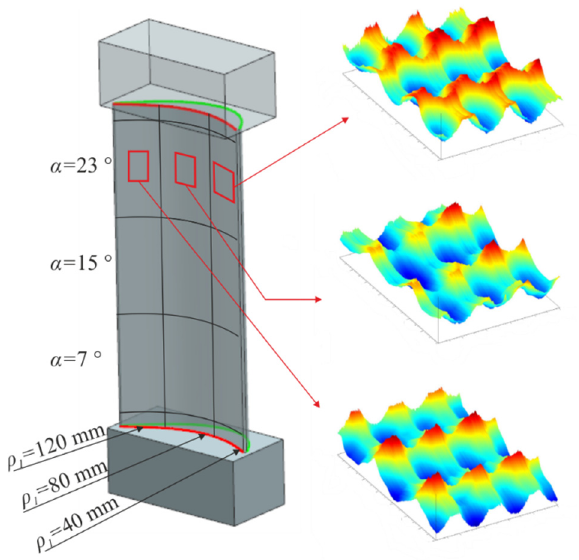
Figure 29. Topography of the concave surface when changing the curvature radius for the lead angle α = 23°.